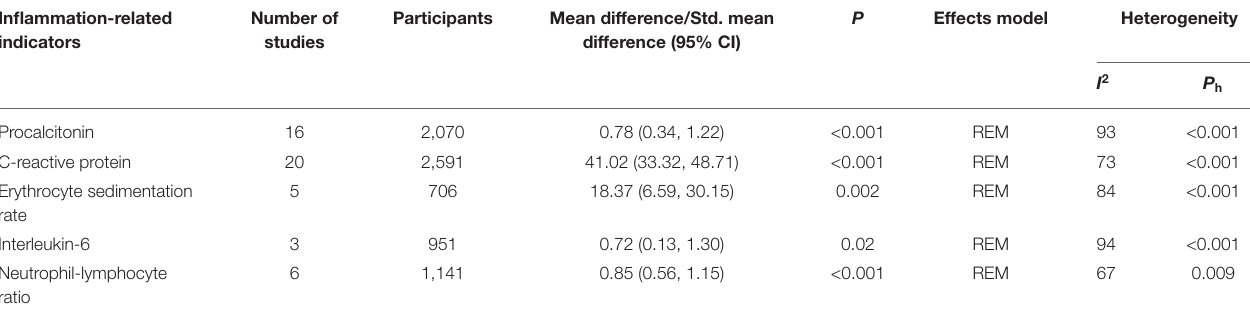
TABLE 3 | The association between inflammation-related indicators and disease severity in patients with COVID-19. Inflammation-related